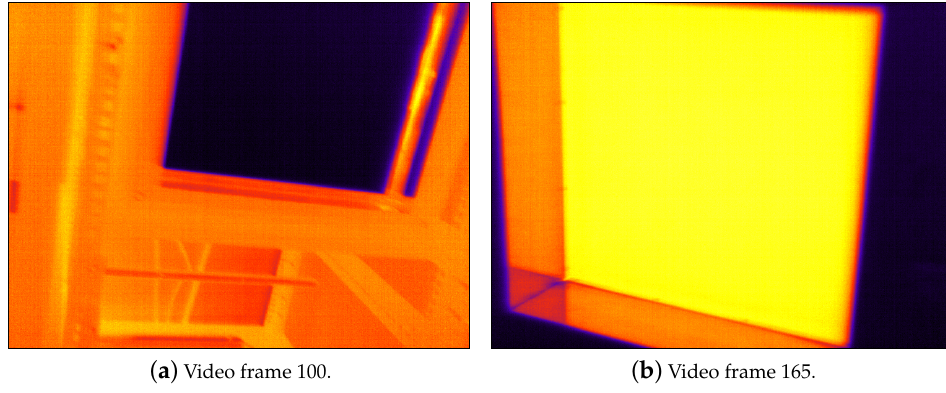
Figure 3. Video frames that introduce large spatial